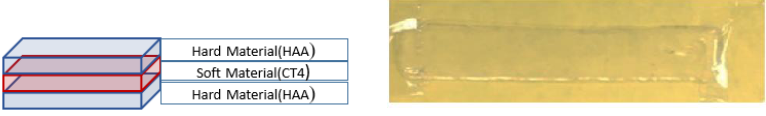
Figure 8. Double-layers multi-materials pads.